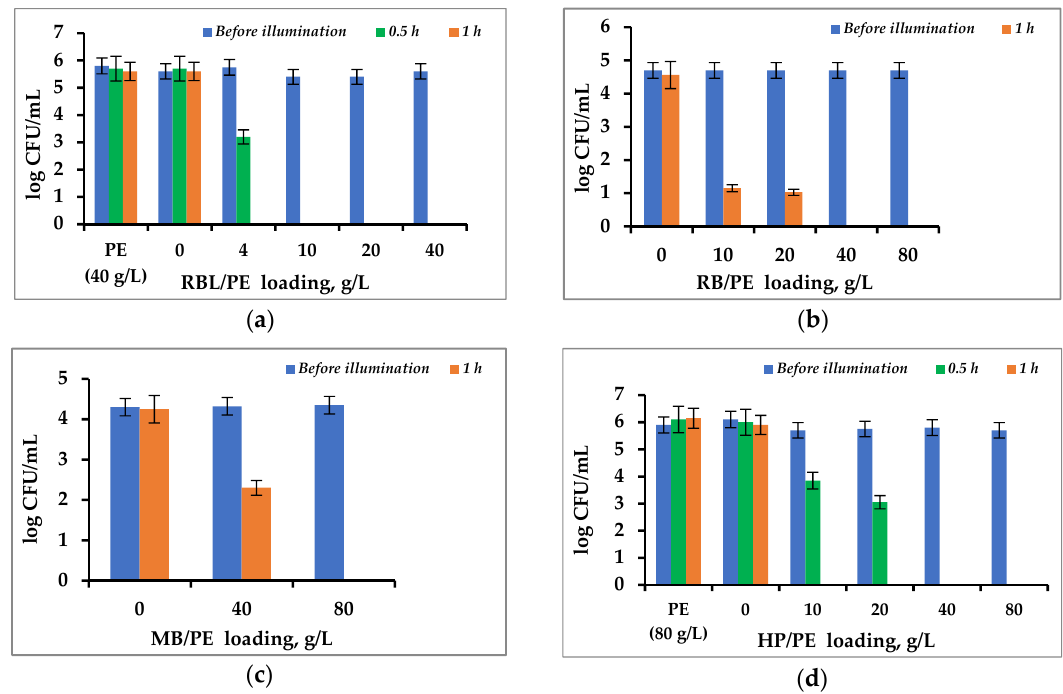
Figure 5. Effect of PS/PE loadings as an amount of PS/PE beads per volume on the eradication of S. aureus under illumination with 1.25 mW/cm 2 white light. ( a ) 1% RBL/PE at an initial cell concentration of 10 6 CFU/mL; ( b ) 1% RB/PE at an initial cell concentration of 10 5 CFU/mL; ( c ) 1% MB/PE at an initial cell concentration of 10 4 CFU/mL; and ( d ) 1% HP/PE at an initial cell concentration of 10 6 CFU/mL.